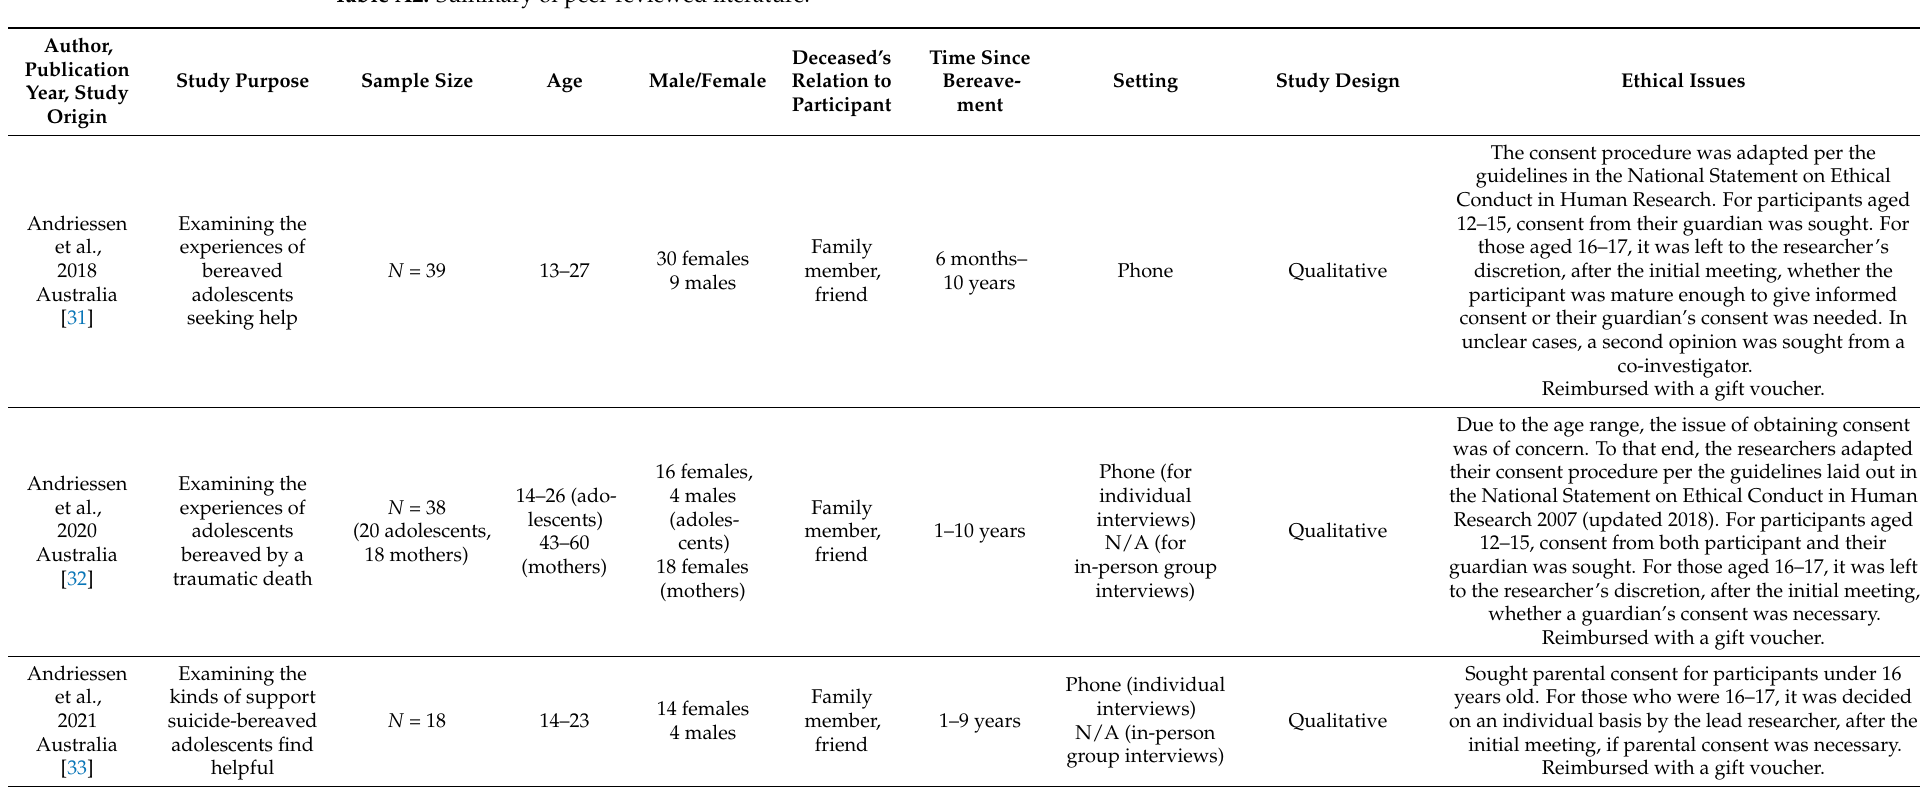
Table A2. Summary of peer-reviewed